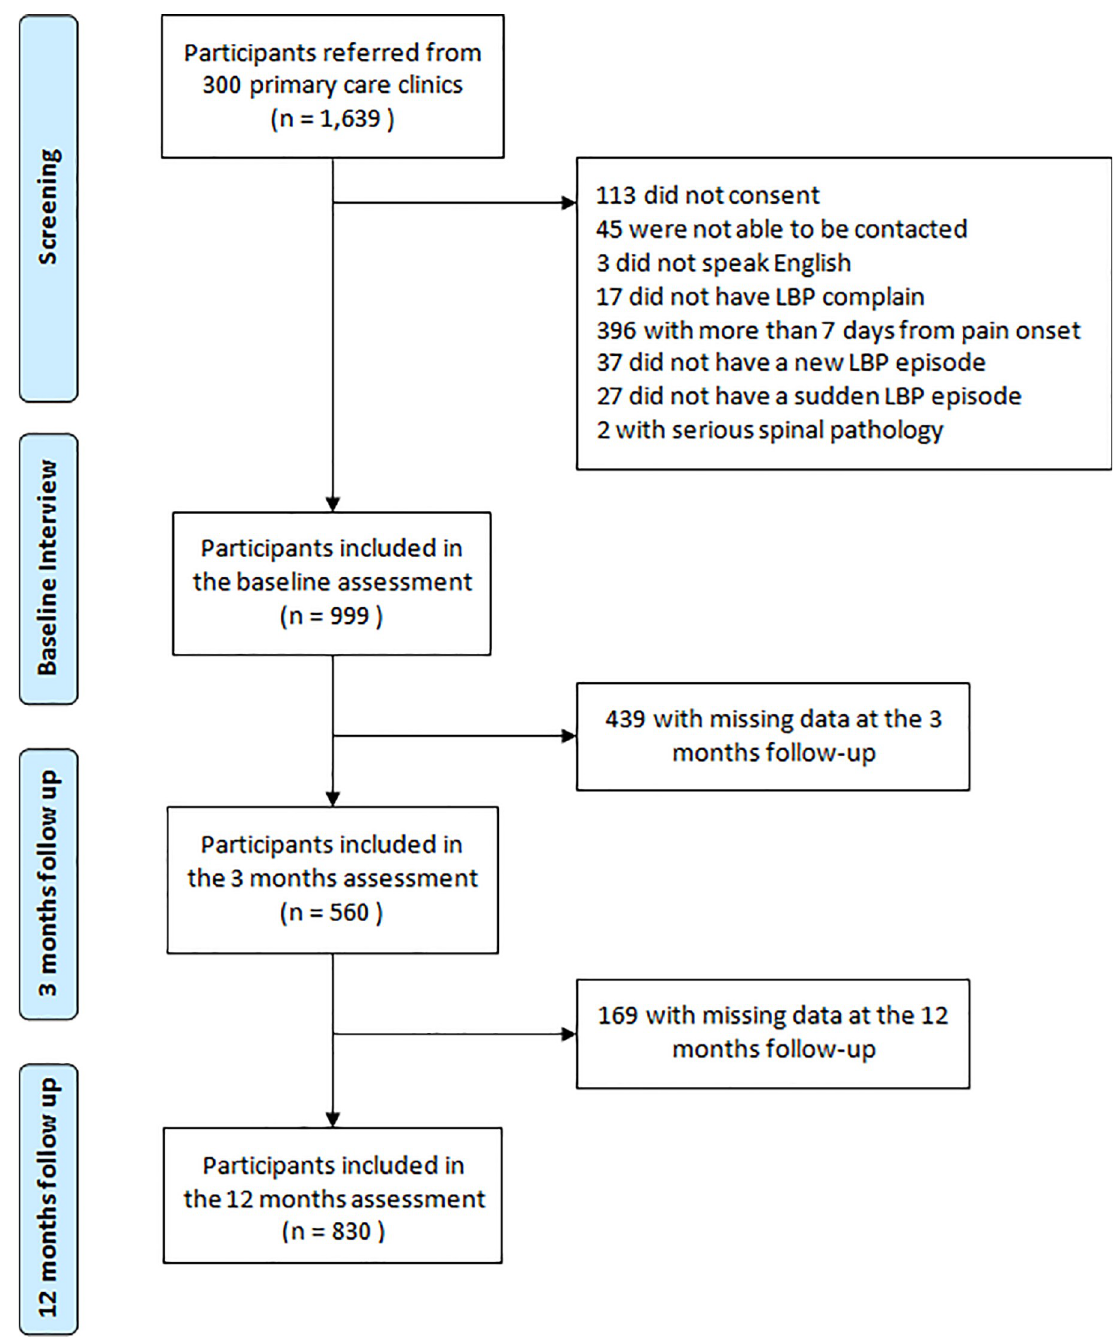
Fig 1. Flowchart of participant’s recruitment and follow-up